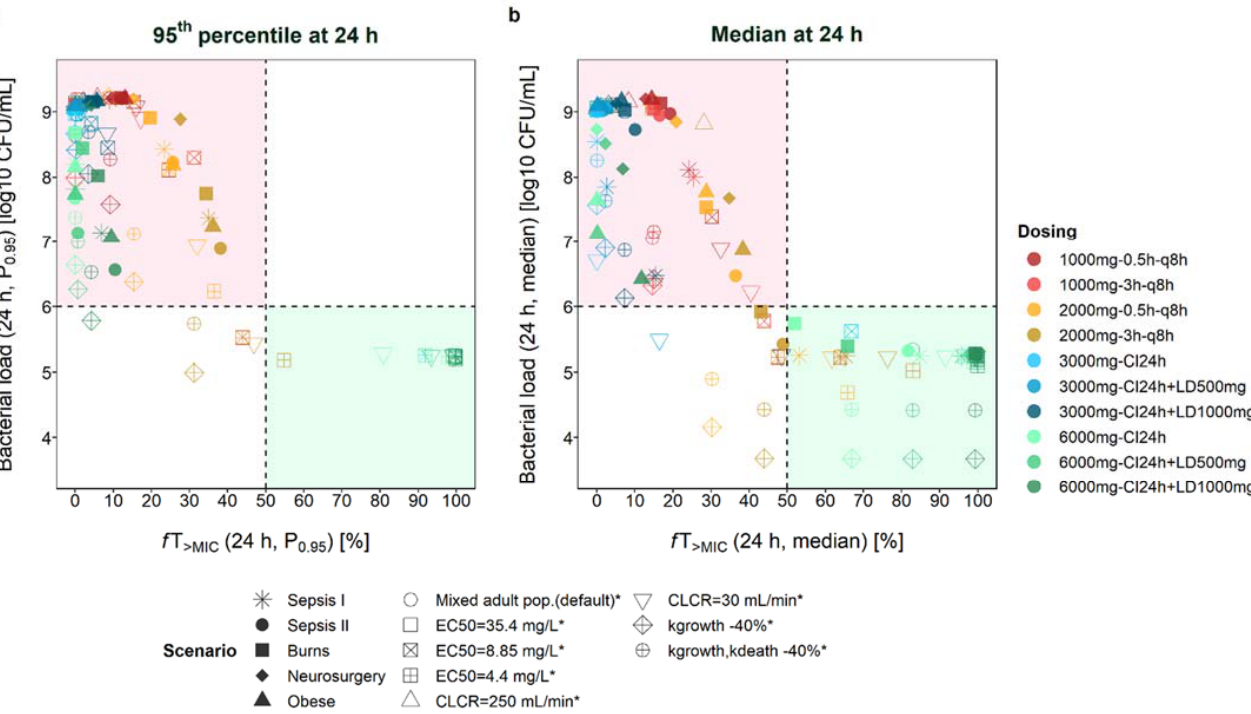
Figure 2. Total bacterial load versus f T >MIC (time that meropenem concentrations exceed the mini- mum inhibitory concentration) reached by 95% (P 0.95 , panel a) or 50% (median, panel b) of the patient population at 24 h after start of therapy given different scenarios. Sepsis I: Delattre et al. [23]; Sepsis II: Roberts et al. [22] (no renal dysfunction); EC 50 : drug concentration that produces 50% of E max